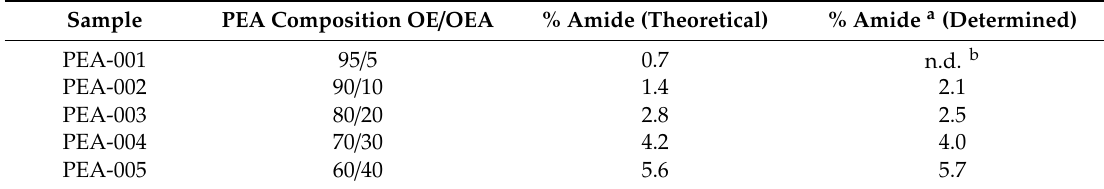
Table 1. Di ff erent compositions and amide content of the PEAs synthetized via the transesterification method.